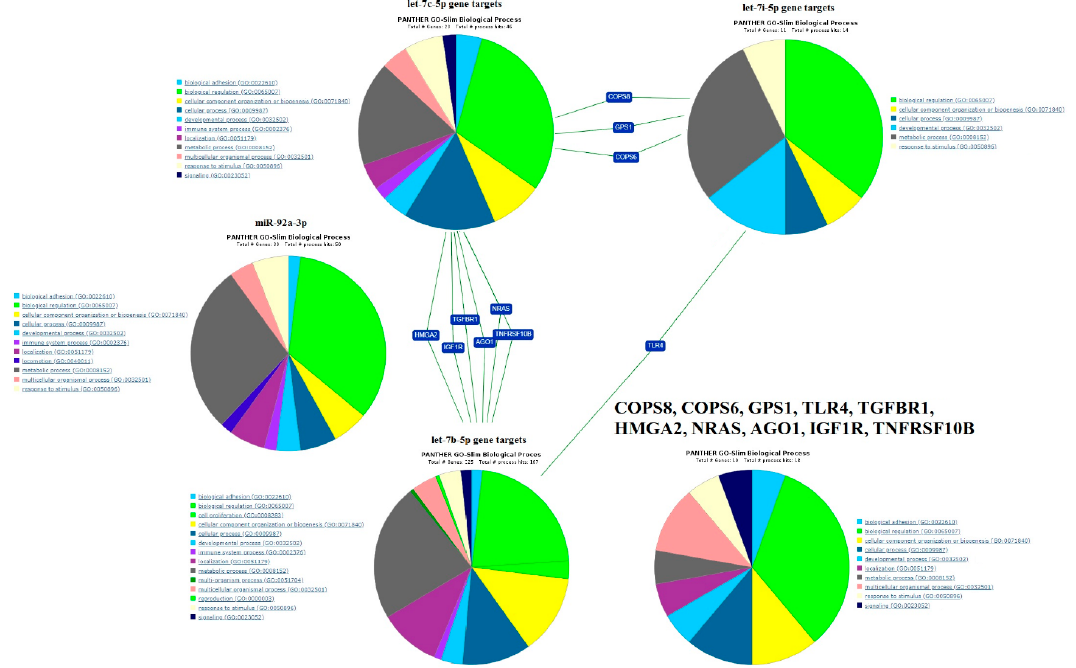
Figure 6. Functional classification of genes targeted by let-7b-5p, let-7c-5p, let-7i-5p, and miR-92a-3p from miRtargetlink and the PANTHER databases.